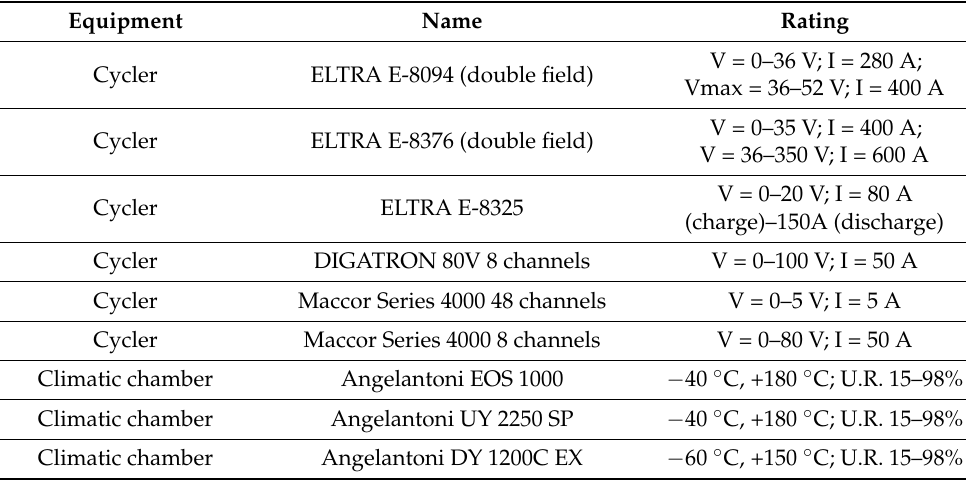
Table 2. Laboratory equipment used in the